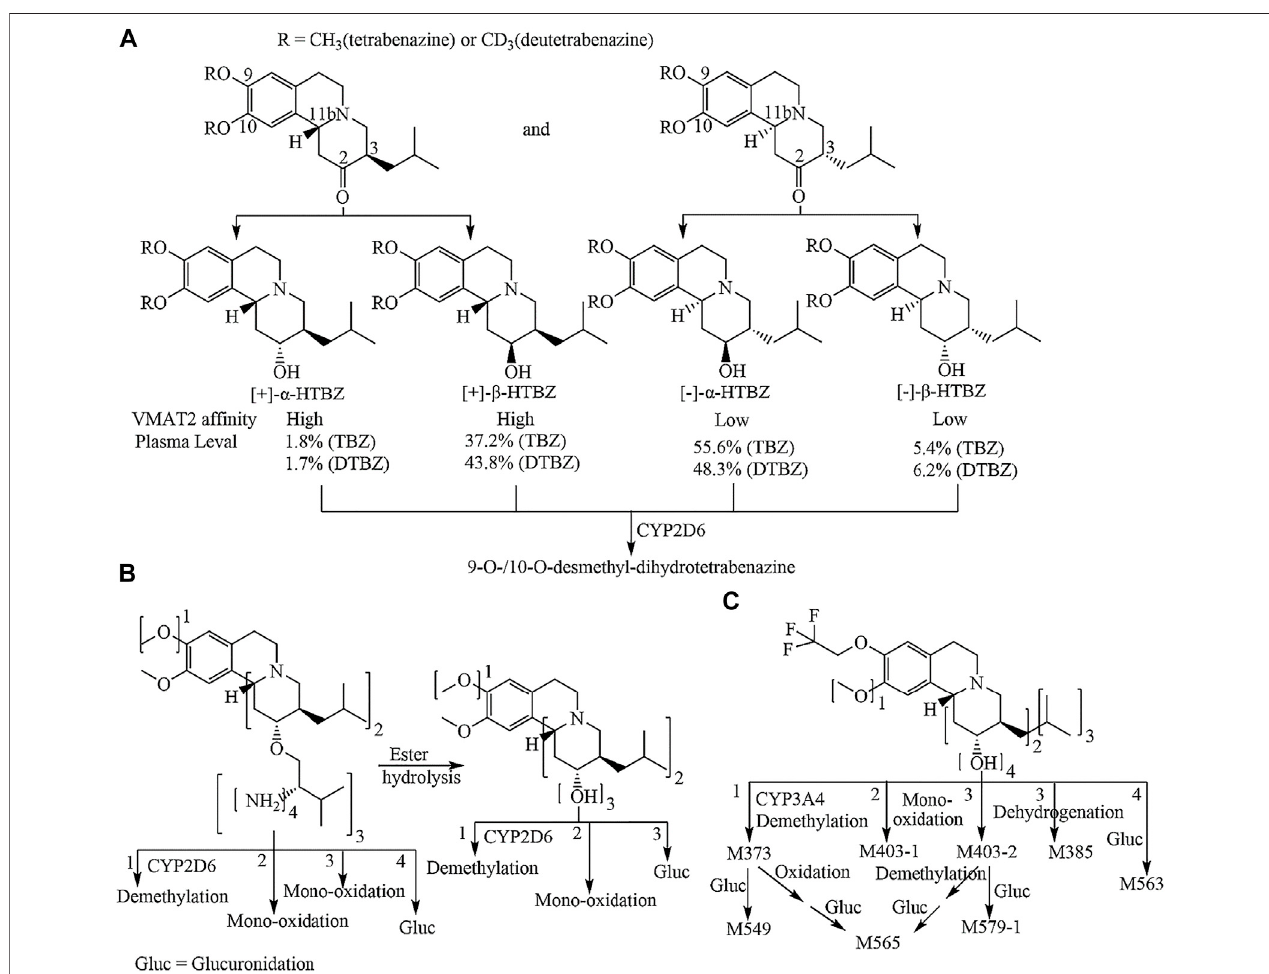
FIGURE 1 | Metabolic pathways of tetrabenazine and deutetrabenazine (A) valbenazine (B) and (+)-9-tri fl uoroethoxy- α -dihydrotetrabenazine [(+)-13e] (C) . Note: the numbers 1, 2, 3 and 4 in B and C are marked outside the square brackets of the chemical group to indicate the metabolic pathway of the corresponding chemical